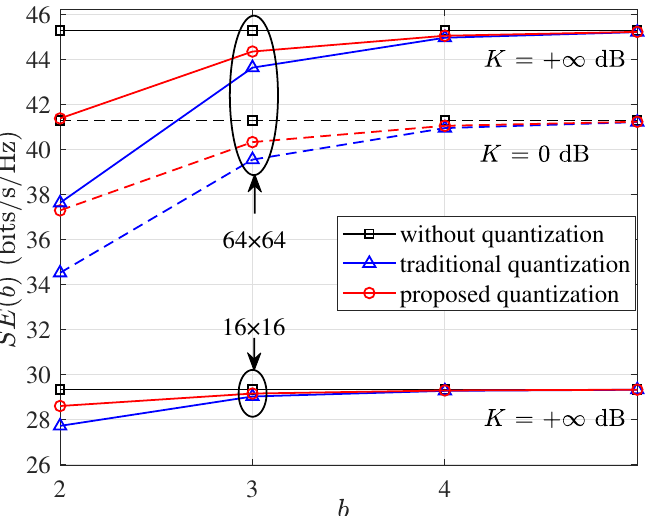
Figure 3. Spectral efficiency SE ( b ) versus quantization bits b with ¯ γ = 10 dB and R = 50 m, where 16 × 16 and 64 × 64 indicate that there are 2 × 2 subarrays at the transceiver, each with 2 × 2 and 4 × 4 antennas,